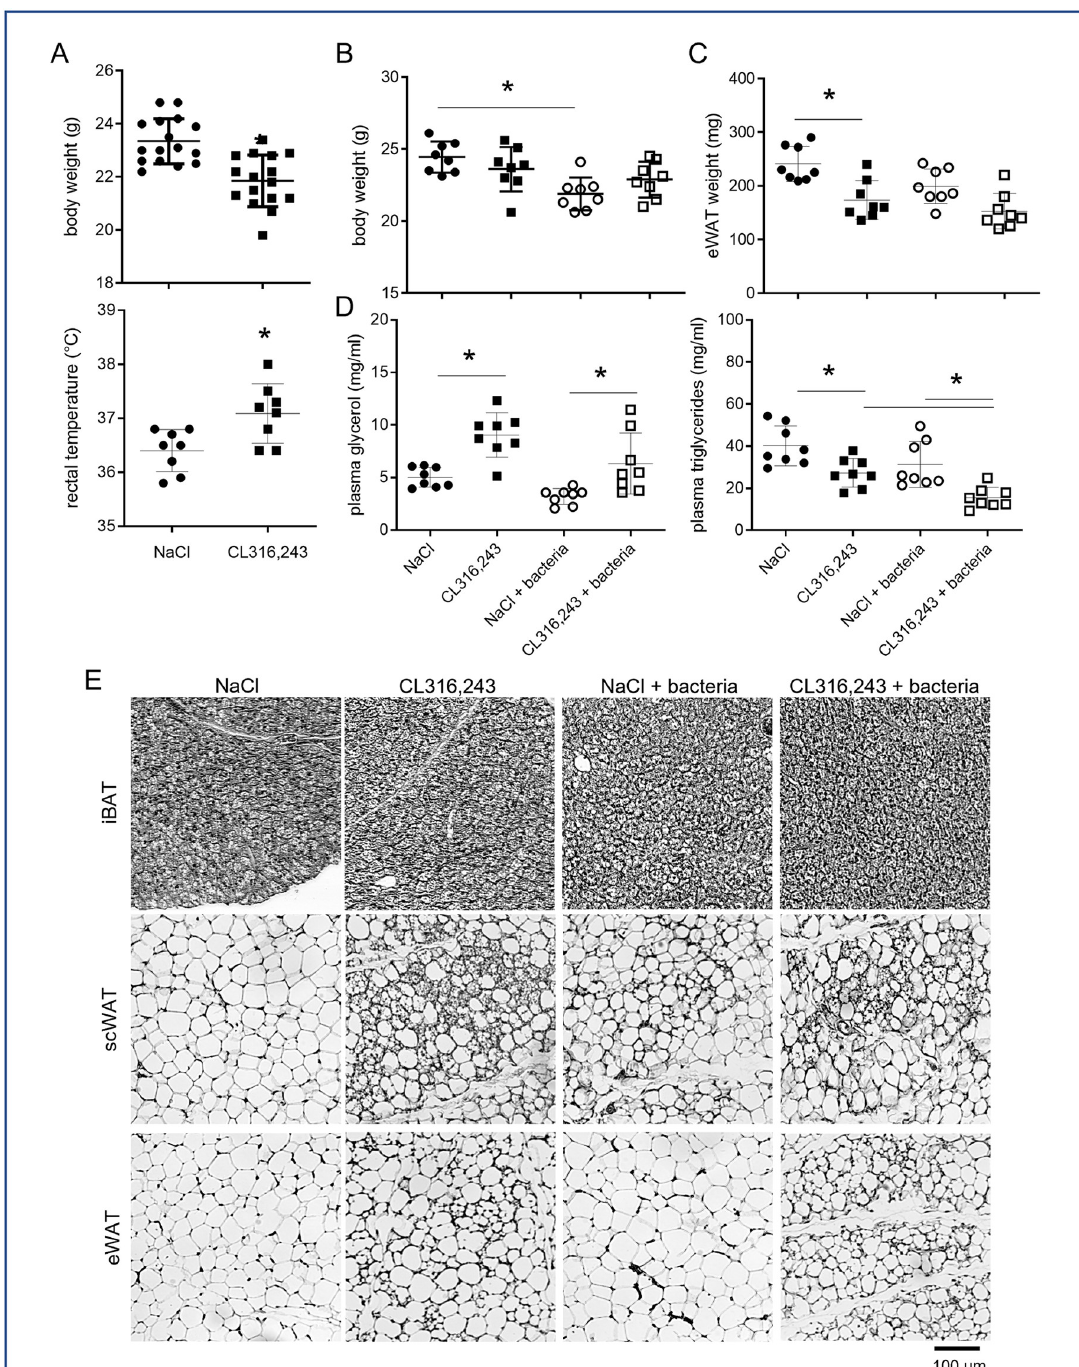
Fig 1. Bacterial infection does not modify metabolic parameters and adipose tissue morphology. Mice were analysed after 1 week of treatment with CL316,243 daily (1 mg/kg/day) or vehicle only (NaCl), and with or without E . coli infection for 48 hours. (A) Mouse body weights and rectal temperatures at the end of CL316,243 treatment. (B) Mouse body weights and (C) epididymal white adipose tissue (eWAT) weights at the end of infection. (D) Triglycerides and glycerol plasma levels at the end of experiment. (E) Representative picture of four haematoxylin-eosin staining of interscapular BAT (iBAT), sub-cutaneous (scWAT) and eWAT sections. The results are displayed as independent values (dots) and the mean ± SD. n = 16 (A) or 8 (B-D). � p < 0.05.